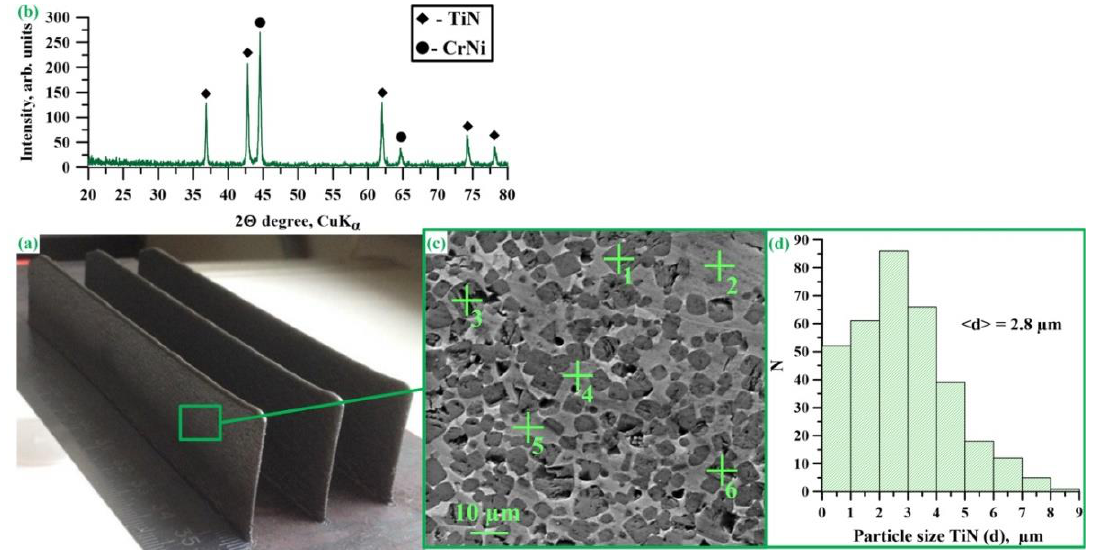
Figure 6. Appearance of the materials obtained by direct laser deposition from CrNi-TiN ( a ), SHS composites, an X-ray diffraction pattern and a SEM image of these materials ( b – c ), a histogram of TiN particle size distribution ( d ).